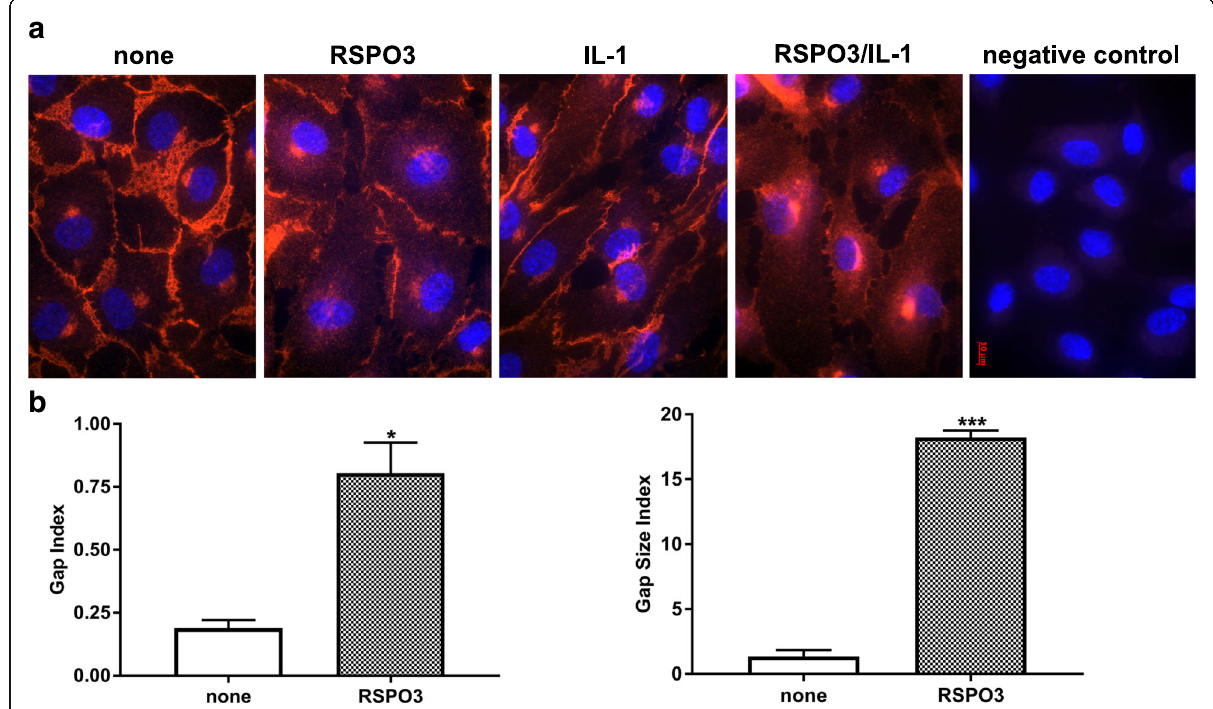
Fig. 2 Inter-cellular gaps in vascular endothelial monolayers treated with RSPO3 or IL-1 β . a Immunofluorescence staining of VE-cadherin (red) and DAPI staining of nuclei (blue) in HCAEC either untreated, or treated with RSPO3, IL-1 β and combined IL-1 β and RSPO3 for 6 h. Microphotographs were taken using a Zeiss Axioskope equipped with Axio-CamMRm and AxioVision Rel.4.6 software and are representative of three independent experiments run in triplicates. Original magnification, 630×. b Quantification of inter-endothelial gap index and gap size index in HCAEC treated with RSPO3. Data are mean ± S.E.M of three independent experiments run in triplicates, * P < 0.05, *** P < 0.001 versus untreated